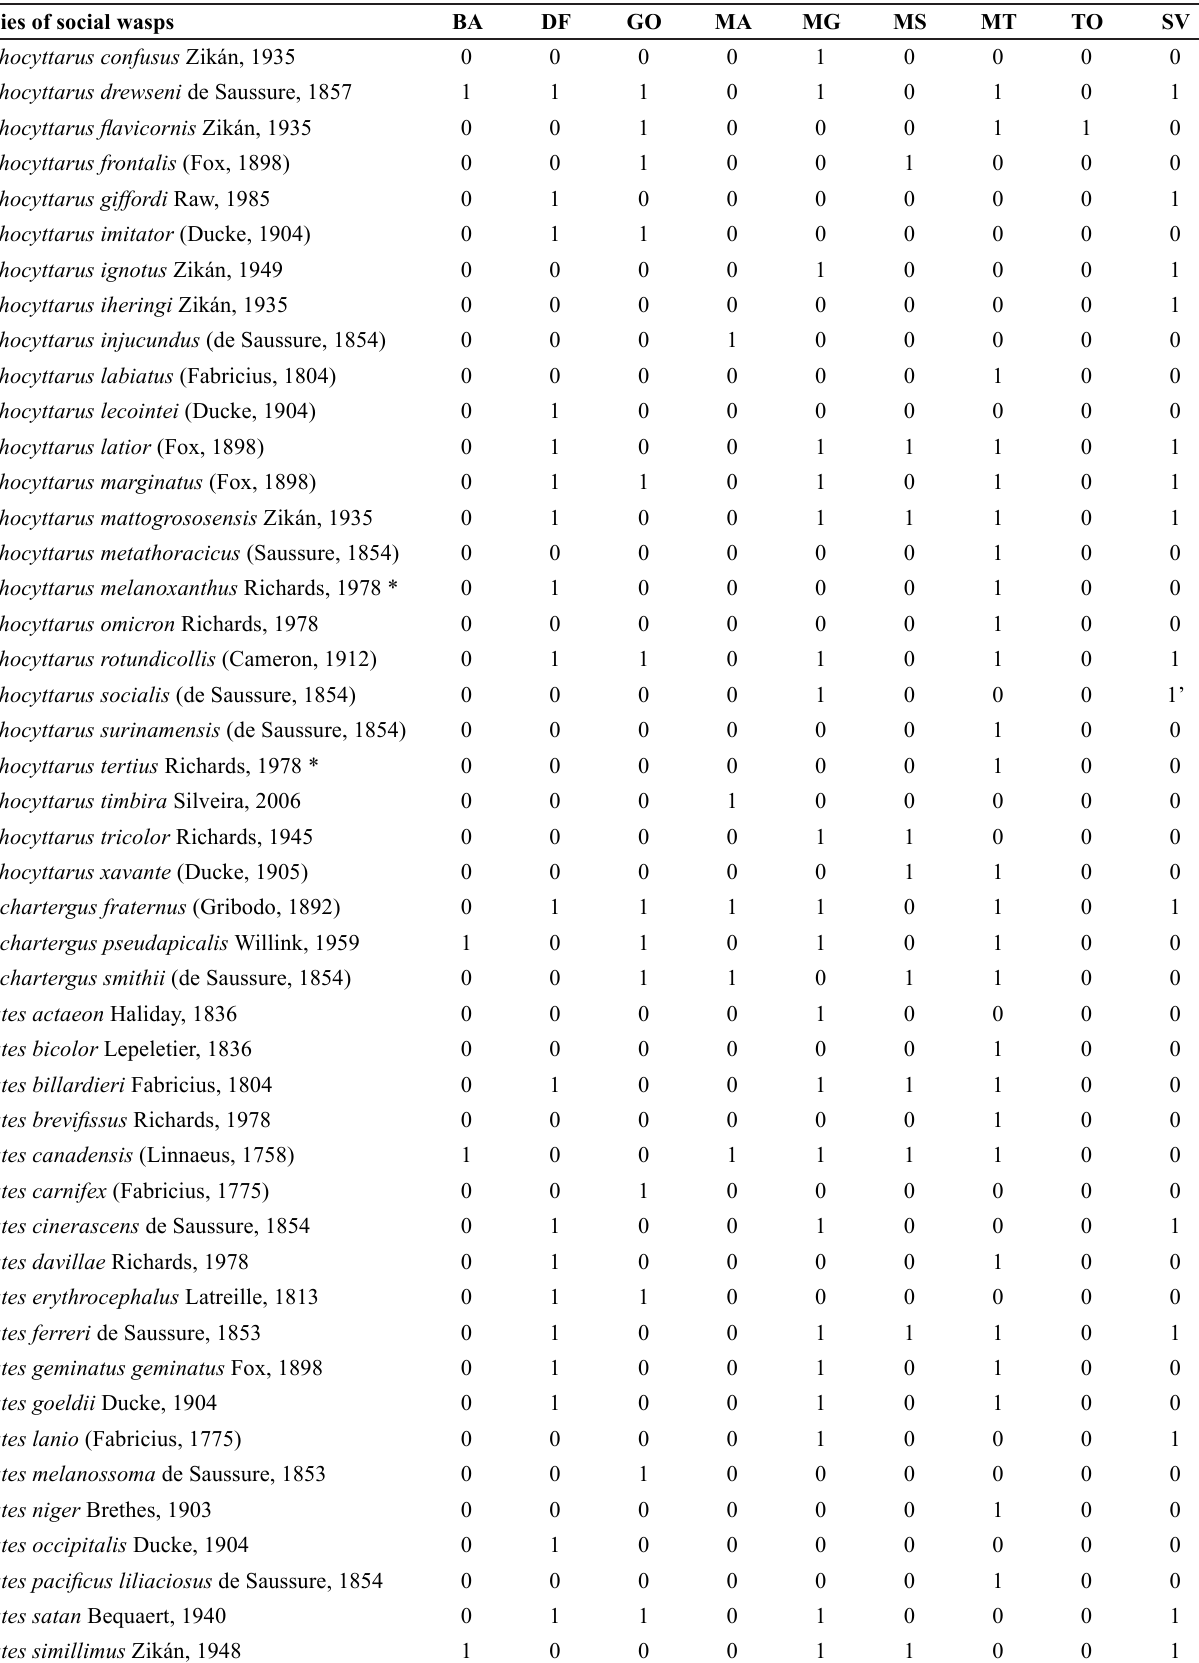
Table 2. Species of social wasps recorded in Cerrado areas in Bahia (BA), Goiás (GO), Maranhão (MA), Minas Gerais (MG), Mato Grosso do Sul (MS), Mato Grosso (MT), Tocantins (TO) and Distrito Federal (DF) states, further data from Sempre-Vivas National Park (SV).